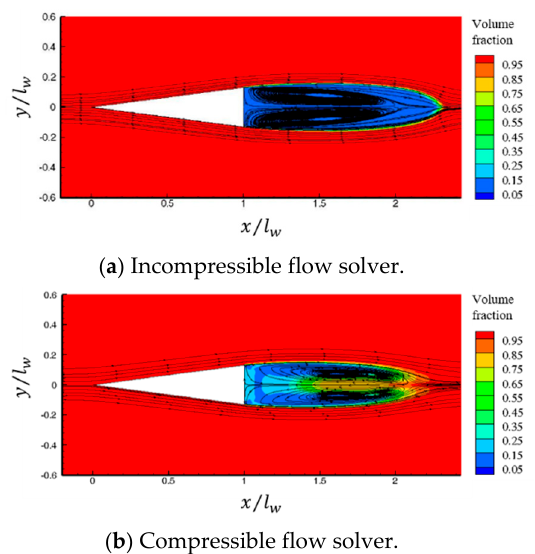
Figure 6. Volume fraction contours and streamlines around wedge at σ = 0.35.